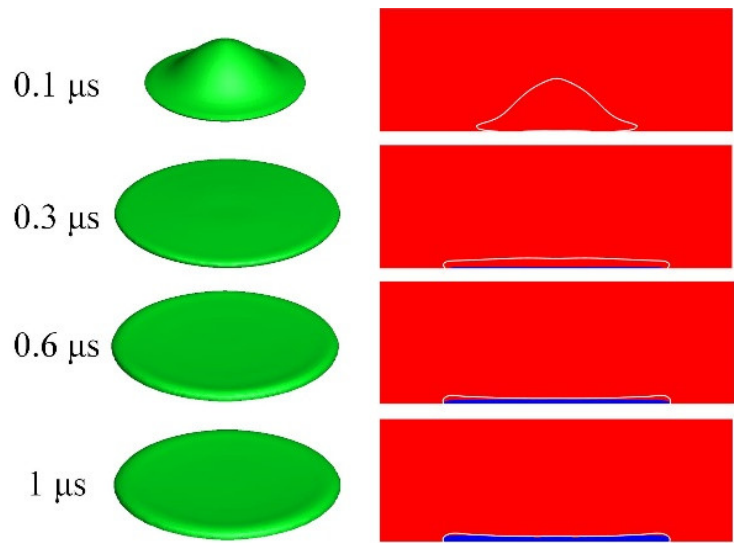
Figure 9. A sequence of snapshots of YSZ drop spreading and their cross-sectional views. At 0.1 µ s, the drop just touches the substrate and, driven by a pressure gradient, makes its way horizontally. Pasandideh-Fard et al. [31] proposed a correlation to predict the time when the drop hits the maximum spread factor, with the critical time t* = tV 0 /D 0 = 2.67. Simple conversion gives t = 0.32 µ s, which is rather close to the numerical prediction, as derived in the spread factor evolution for this case with Cn = 1/60 in Figure 4. When time progresses to 0.3 µ s, only a small portion turns solidified. Hence, though solidification occurs as early as in the spreading phase, it could not inhibit YSZ drop spreading because of a lower heat transfer rate. Subsequently, with the combined action of surface tension and solidification, the drop profile takes on a pancake shape but with a thickened rim, which is visually recognizable. This could still be ascribed to a lower heat transfer rate so that surface tension could have time to round and thicken the rim. The total solidification time could be estimated from a correlation in [32].